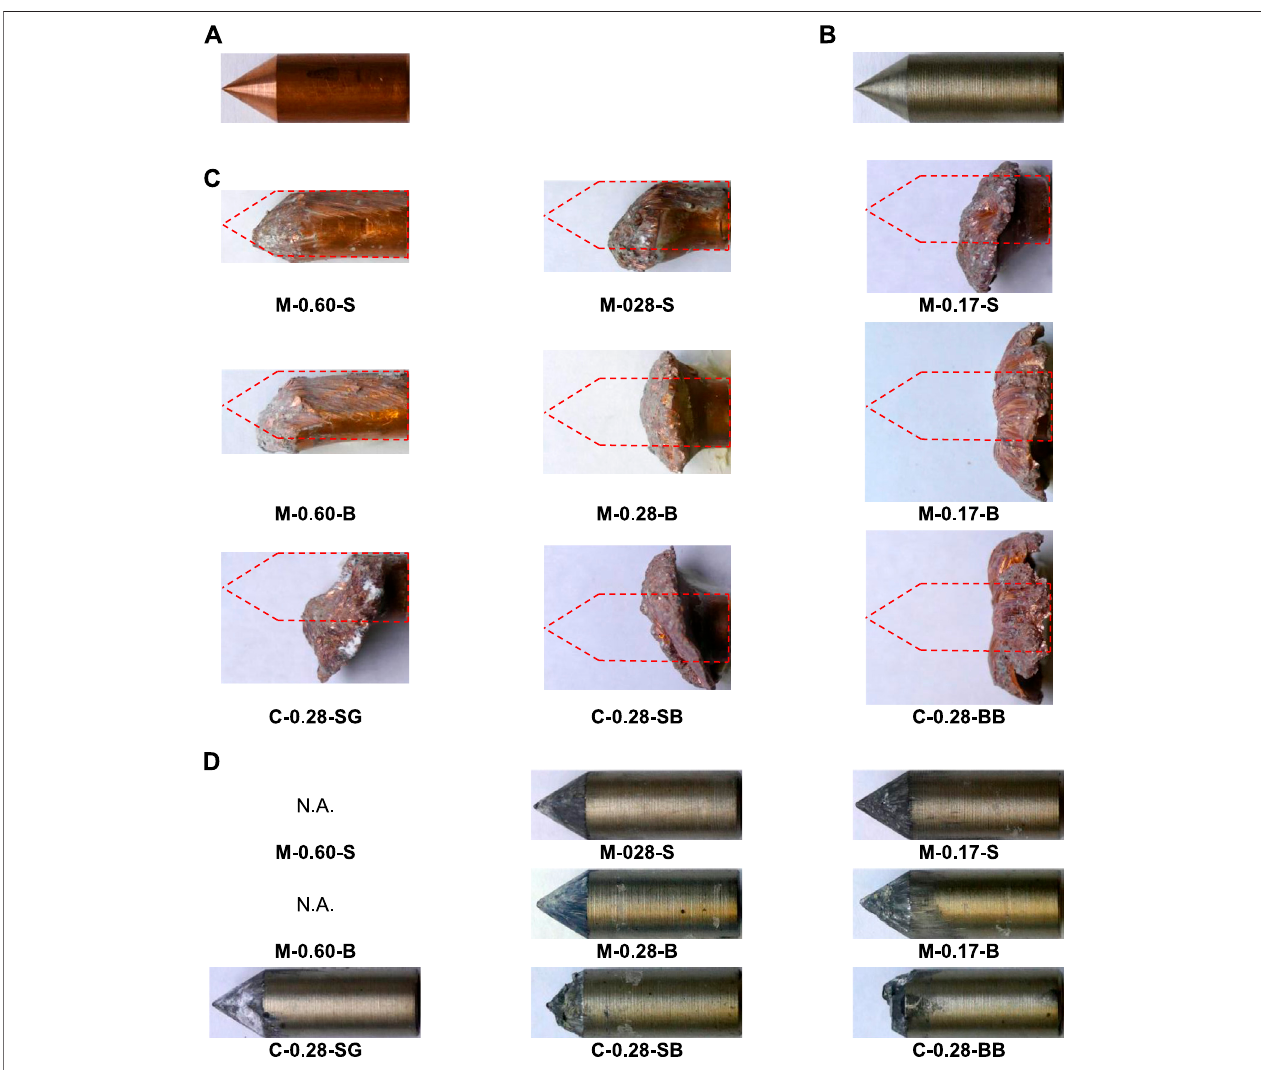
FIGURE 4 | Images of (A) original copper projectile, (B) original steel projectile, (C) post-HVPI test copper projectiles, and (D) post-HVPI test steel projectiles..